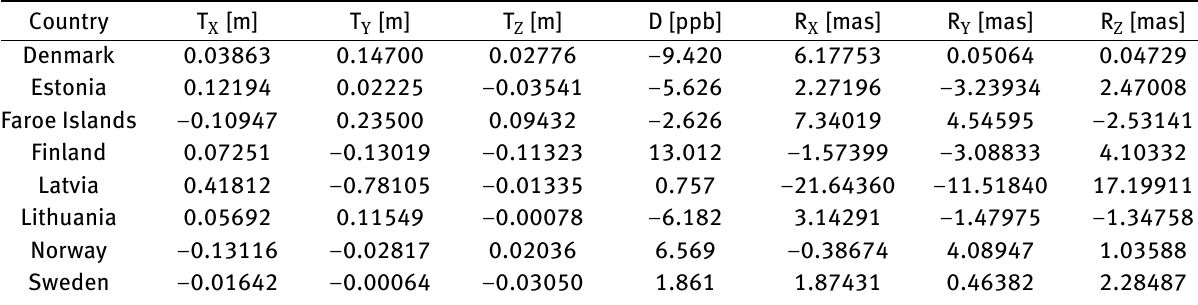
Table 8: Transformation parameters P NKG 1, CC from the common NKG reference frame NKG ETRF 00 to national ETRS89 realizations at the epoch 2000.0, ETRFyy(2000.0). Transformation is defined and parameters given at the epoch 2000.0. Parameters P NKG 1, CC are associated and should be used only with intraplate corrections from the re-aligned NKG RF 03 vel model ( NKG RF 03 vel ETRF 2000 ), see Fig. 2 for more details.